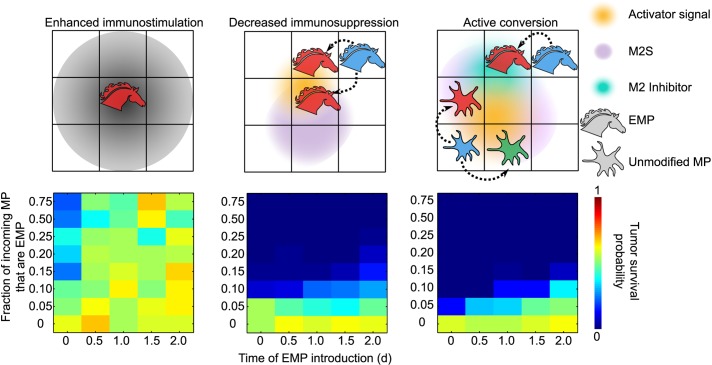
Evaluation of potential engineered cell-based therapy strategies.Three potential strategies to treat cancer with engineered macrophages (EMP) were evaluated for efficacy in promoting tumor clearance in this model of the early TME. Enhanced immunostimulation (left column): when polarized to the M1 state, EMP released four times the base case level of TLS. Decreased immunosuppression (center column): EMP could not polarize to the M2 state. Active conversion (right column): EMP could not polarize to the M2 state and constitutively secreted a diffusible signal that blocked the M2 receptor on normal (unmodified) macrophages. For each strategy, tumor survival probability was calculated over simulations varying the time at which the first EMP were introduced and the fraction of incoming MP that were MP (vs. unmodified); 50 simulations were performed for each case.